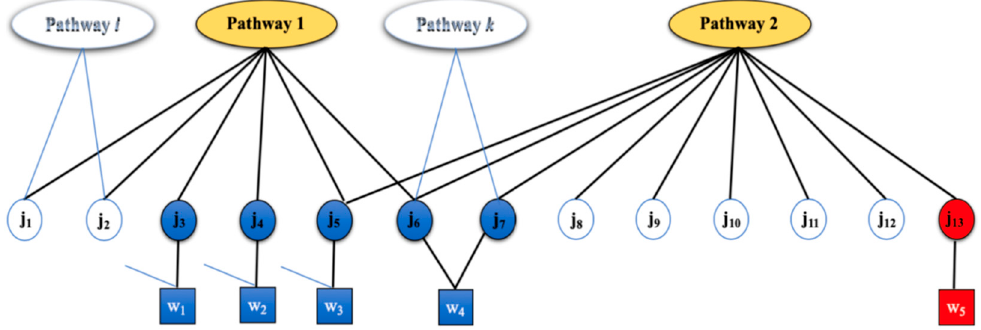
Figure 1. Illustrative example of uncertainty when mapping measurements to metabolites and pathways. Pathways (ovals) are associated with metabolites (circles), which in turn are associated with measurements (square). White circles represent non-measured metabolite with membership in one or more pathways. Blue circles represent measured metabolites that have multiple-pathway memberships (multiple-pathway membership is assumed but not shown for j 3 and j 4 ). The red circle represents a metabolite that has membership in only one pathway. Measurement w 5 uniquely maps to j 13 , which uniquely maps to Pathway 2, while all other measurements map to multiple metabolites, as shown by solid or dotted lines.